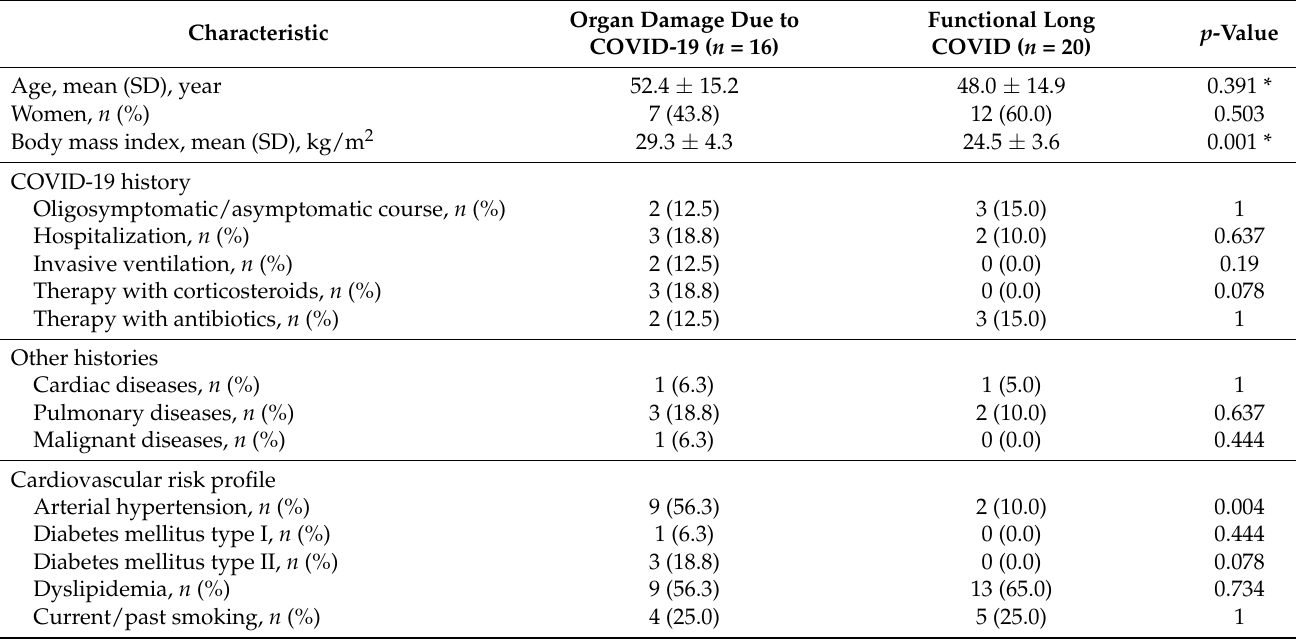
Table 3. Comparison of patients with a clear indication of organ damage due to COVID-19 in Step 2 diagnostics with patients without “functional long